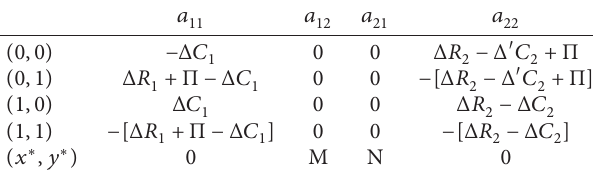
Table 2: Determinant values and traces of local equilibrium